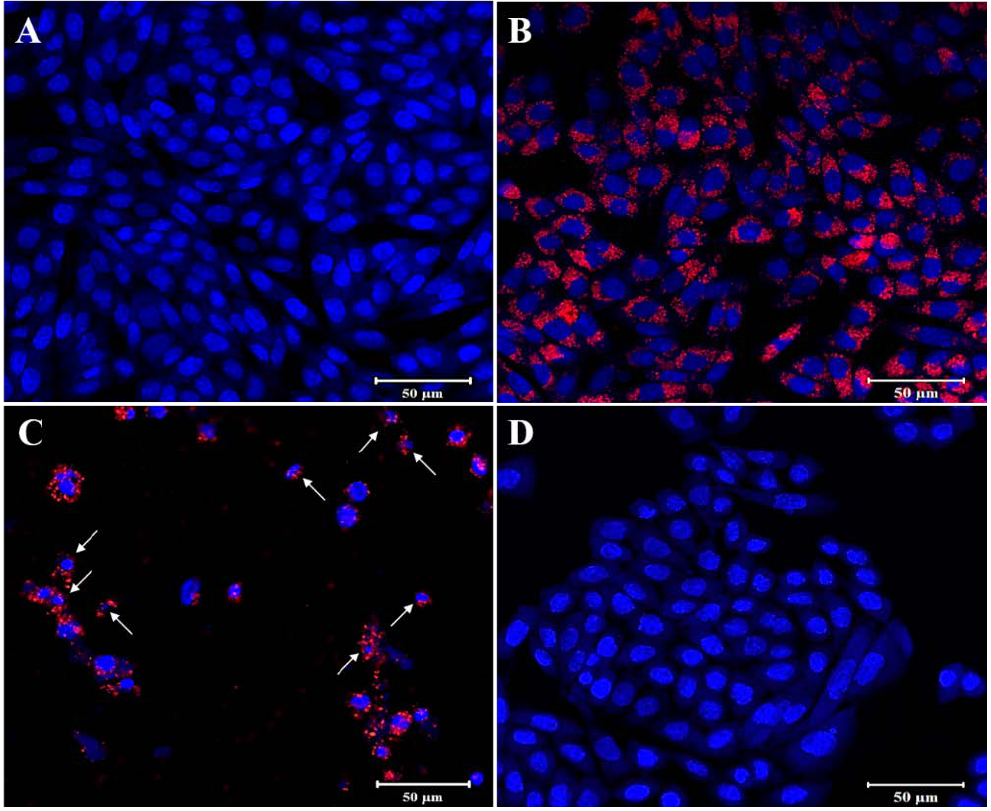
Figure 9. Confocal laser scanning microscopy images of HELA cells after 24 h of treatment. In the images, NR is shown in red color and the nucleus is stained with Hoechst in blue. ( A ) Control (no treatment), ( B ) PMMA-NR treatment (71.83 µ g / mL), ( C ) PMMA-NR-Si-TAM treatment (71.83 µ g / mL), ( D ) TAM treatment (71.83 µ g / mL). The arrows indicate the nucleus structural changes. White arrow: DNA condensation. These images clearly showed e ffi cient uptake of PMMA-NR and PMMA-NR-Si-TAM by the HELA cells. Scale bar: 50 µ